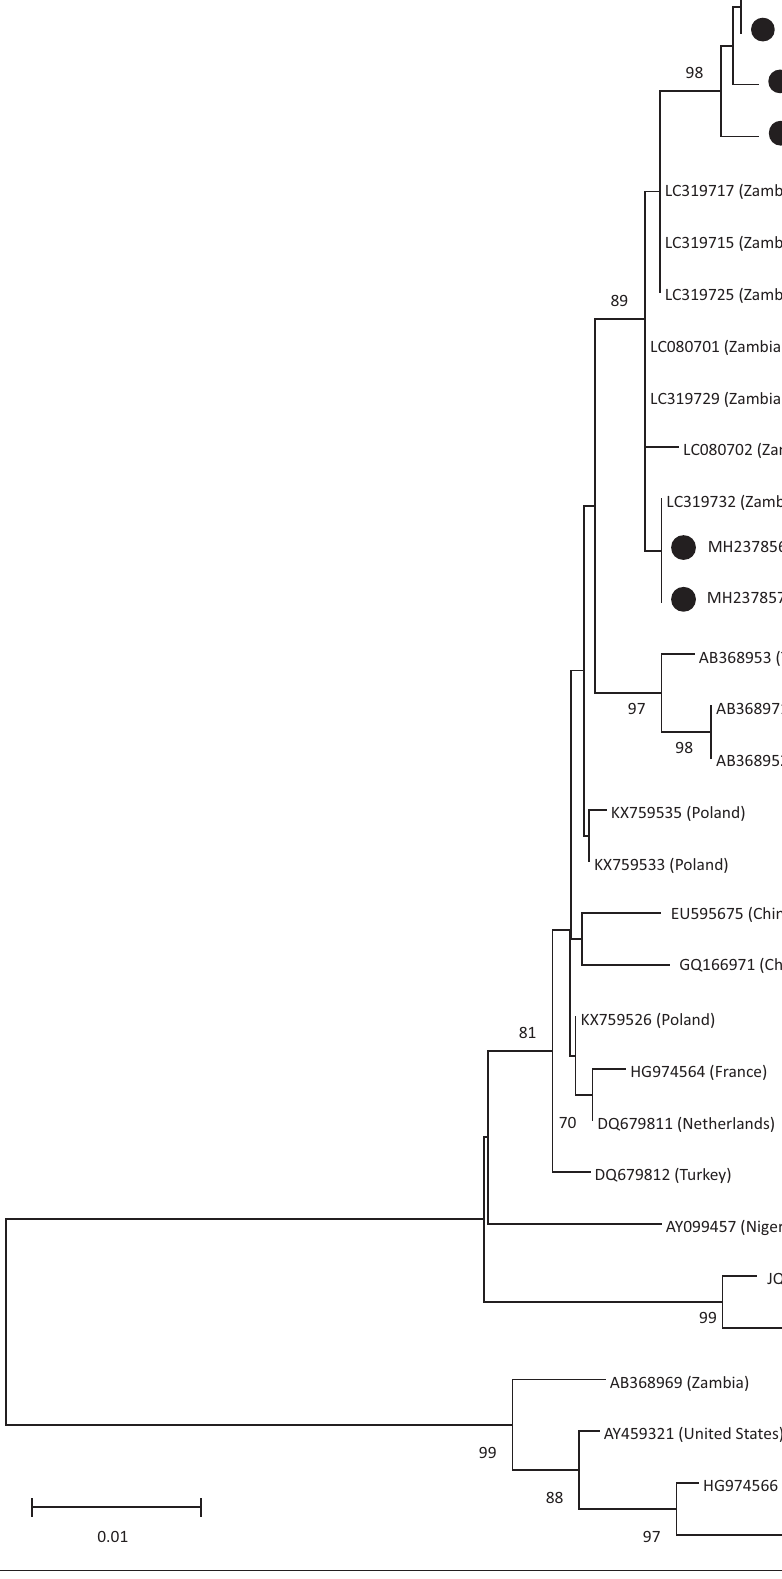
FIGURE 2: Neighbour-joining analysis using the MEGA6 software of a partial nucleotide sequence (688 bp) of the VP1 gene from the infectious bursal disease virus samples investigated (filled circles) and representative sequences from GenBank. The numbers indicate the bootstrap values calculated from 1000 bootstrap replicates. The scale bar represents nucleotide substitutions per site. The different Genogroups are indicated as described by Michel and Jackwood